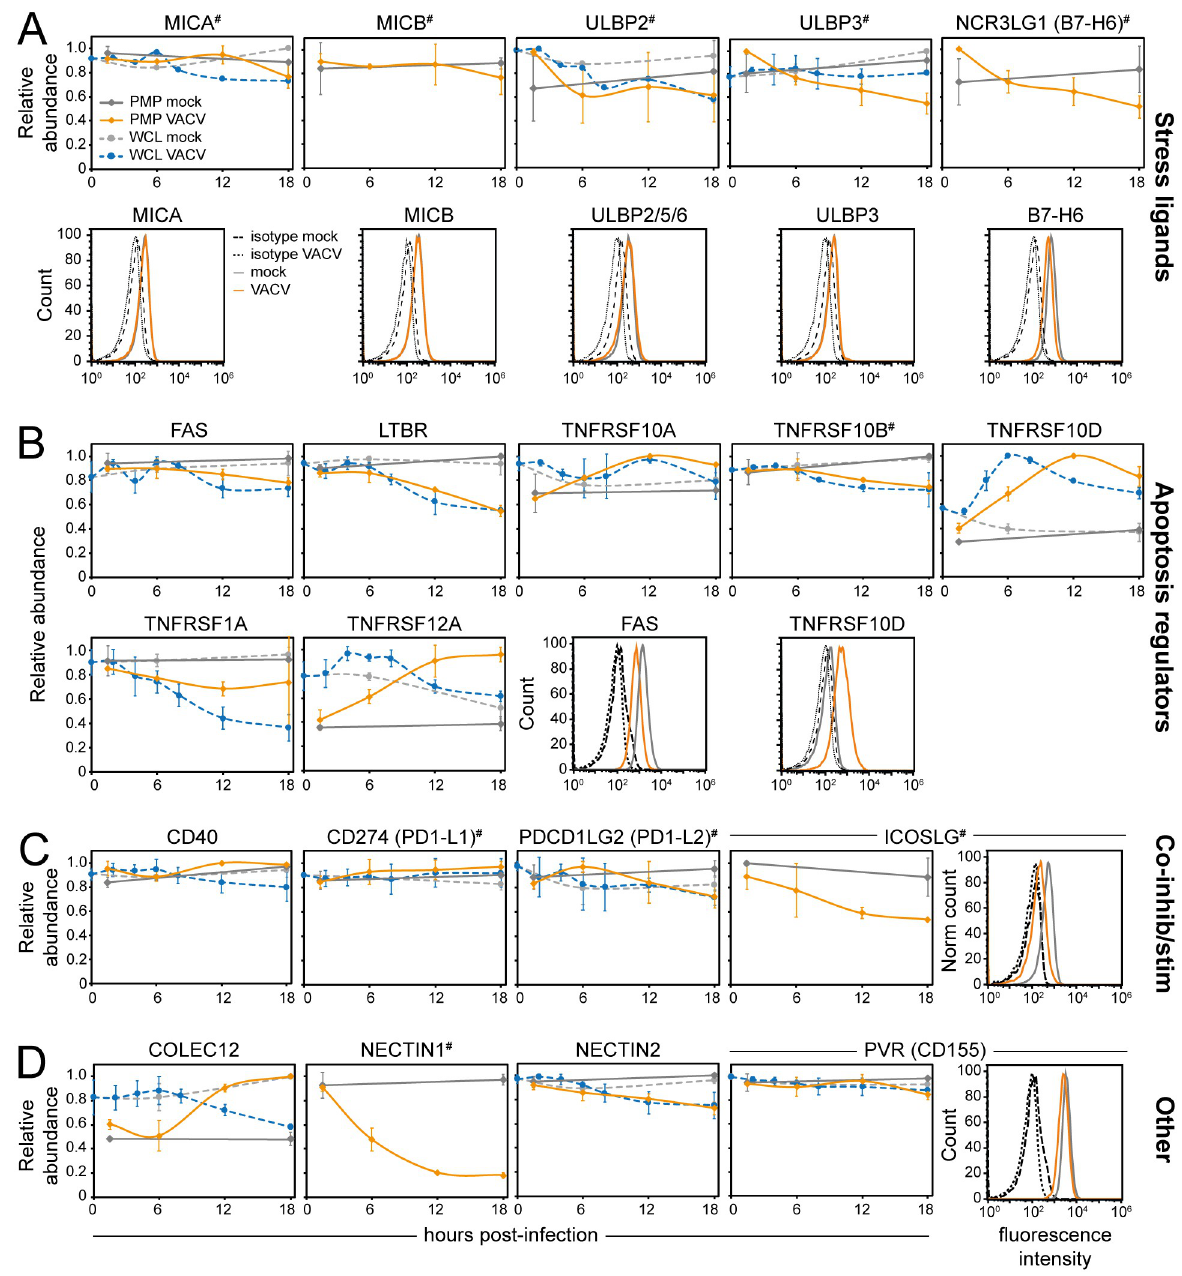
Fig 4. Cell surface expression of immune cell ligands is selectively modulated during VACV infection. Temporal profiles showing the cell surface and whole-cell expression levels of ( A ) stress ligands for NKG2D receptor, ( B ) apoptosis regulators, ( C ) co-inhibitory/stimulatory ligands and ( D ) other immune ligands. Data are represented as mean ± SD (PMP n = 2; WCL [9] n = 3, # WCL n < 3). Cell surface downregulation of selected proteins during VACV infection was confirmed by flow cytometry in HeLa cells (stress ligands & TNFRSF10D), HFFF-TERTs (FAS & PVR) or DOHH2 cells (ICOSLG) at 15–18 hpi. Results are representative of at least two independent